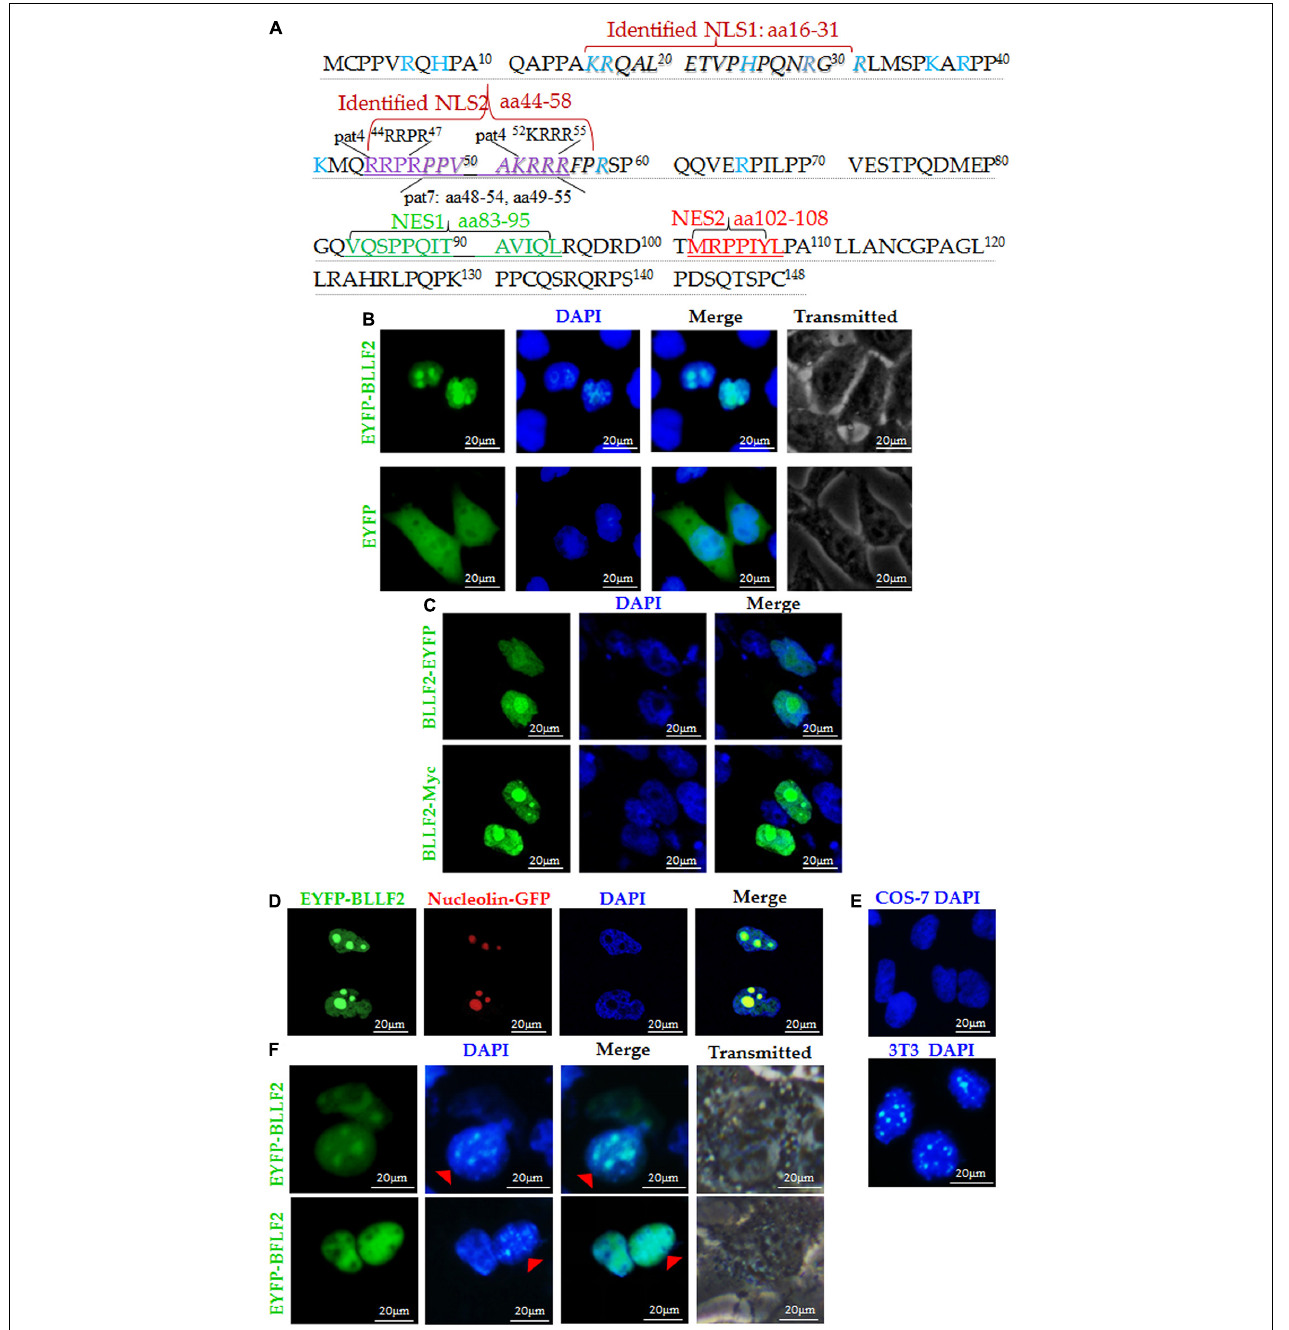
FIGURE 1 | Subcellular localization and nucleocytoplasmic shuttling of BLLF2. (A) Potential NESs and NLSs of BLLF2 were predicted by the bioinformatics software NetNES 1.1 and PSORT II, respectively. Proteins assigned for trafficking into the nucleus encompass aa targeting sequences termed NLSs (Lange et al., 2007), and proteins bound for delivery out of the nucleus consisting of aa targeting sequences named NESs (La Cour et al., 2004). The basic aas are arginine (R), histidine (H), and lysine (K). PSORT II adopts the following two standards to dissect target protein: four-residue pattern (termed “pat4”) formed by four basic aa (K or R), or formed by three basic aa (K or R) and either H or P; the other (termed “pat7”) is a pattern beginning with P and followed within three residues by a basic segment including three K/R residues out of four. The identified NLSs 16 KRQALETVPHPQNRGR 31 (NLS1) and 44 RRPRPPVAKRRRFPR 58 (NLS2) were also indicated. (B) Subcellular distributions of EYFP-BLLF2 and EYFP vector in COS-7 cells. (C) Subcellular distributions of BLLF2-EYFP and BLLF2-Myc in COS-7 cells. (D) Co-expression of EYFP-BLLF2 and pNucleolin-EGFP was observed in COS-7 cells. (E) COS-7 and NIH3T3 cells were stained with DAPI. NIH3T3 cells were identified by their speckled nuclei. (F) Nucleocytoplasmic shuttling of BLLF2 was demonstrated by interspecies heterokaryon assays. EYFP-BFLF2 was used as nucleocytoplasmic shuttling positive control. COS-7 and NIH3T3 cells were discriminated against by nuclear staining with DAPI. NIH3T3 cells were identified by their speckled nuclei (red arrowhead). All scale bars indicate 20 µ